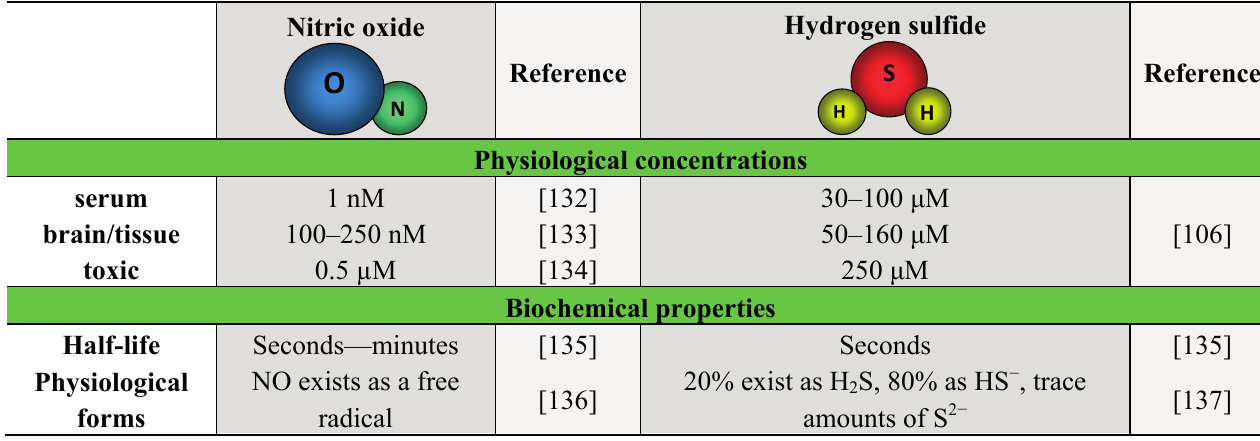
Table 1. Nitric oxide and hydrogen sulfide biochemistry and